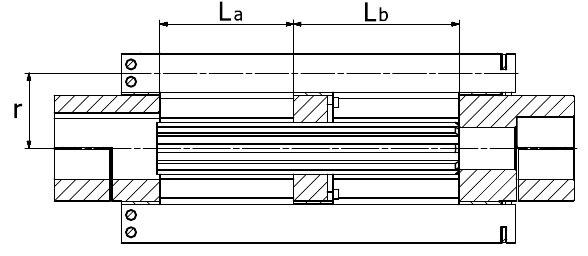
Fig. 2. Dimensions used in the